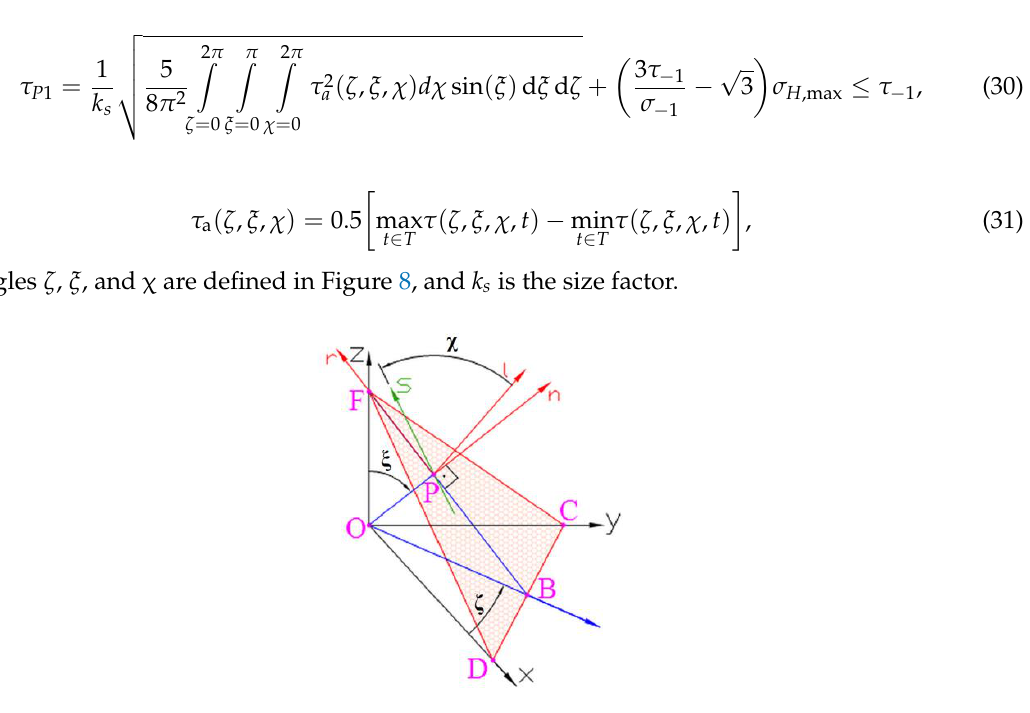
Figure 8. Orientation of material plane Δ(CDF) crossing point O (point P tends to point O); angle χ defines the direction of versos s on material plane Δ; versor n is perpendicular to material plane Δ.